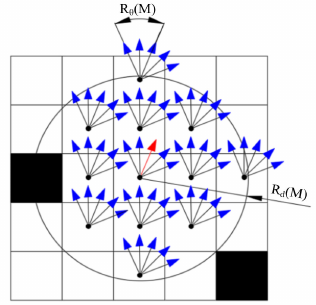
Figure 2. Schematic diagram of M . The black grids and white grids indicate the occupied cells and free space cells, separately. The R d ( M ) and R θ ( M ) are marked on this figure. The position and the direction of the red arrow represent the pose x to be evaluated. Those blue arrows represent those poses derived from the incremental pose set M and x according to x + ∆ i